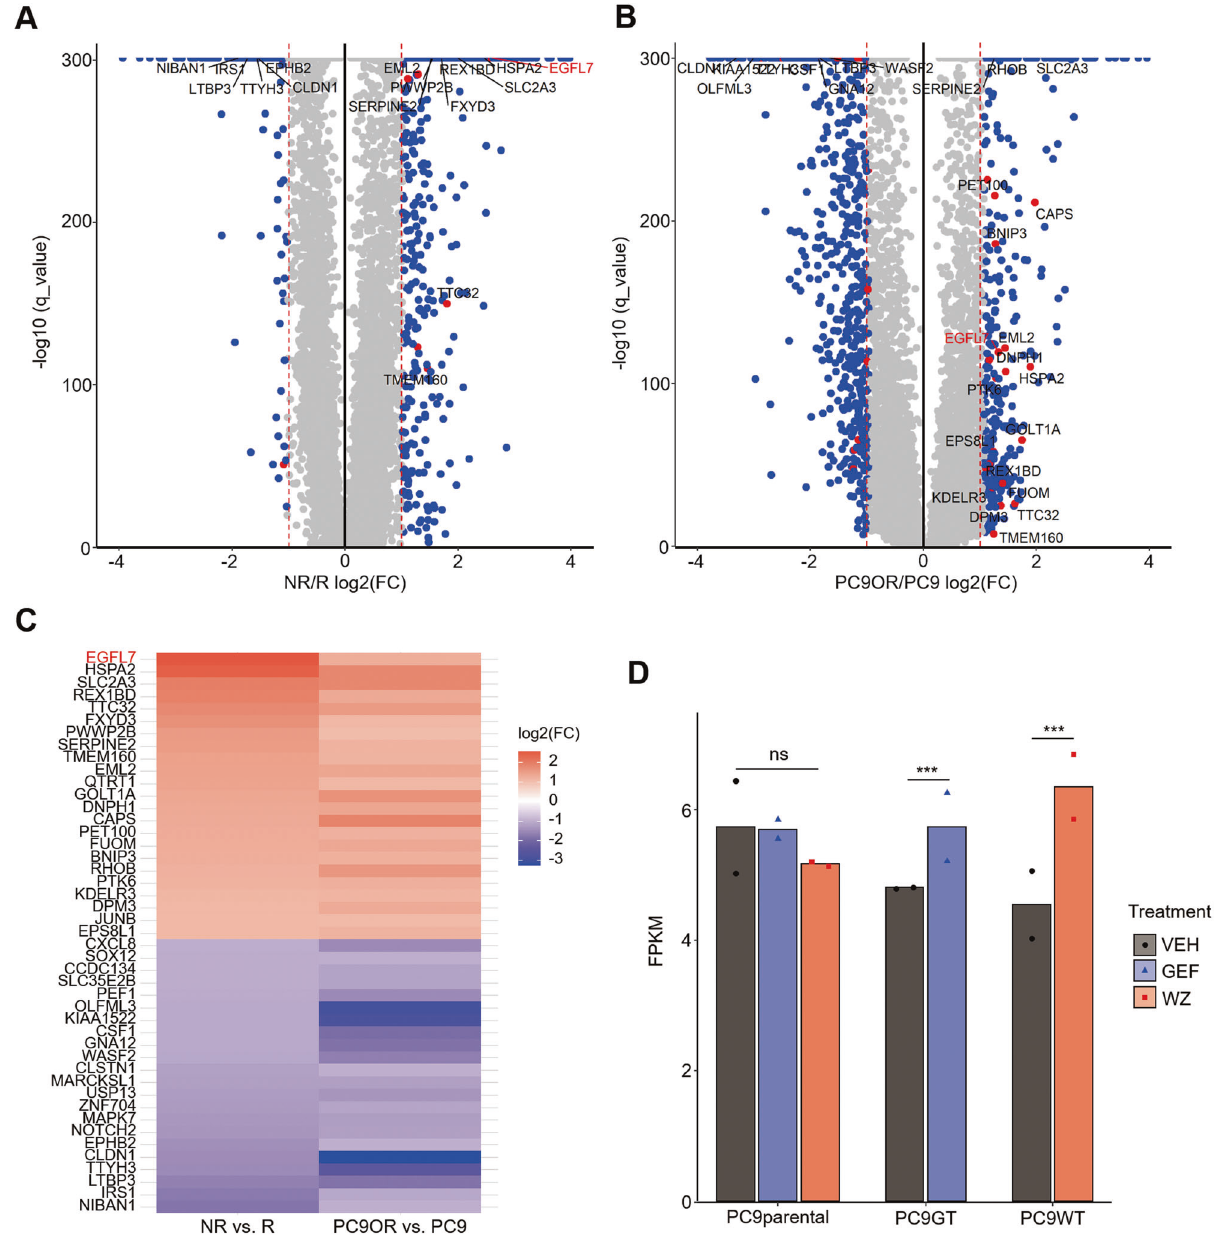
Fig. 1 EGFL7 correlates to EGFR inhibitors resistance in cancer. A Volcano plot representing differential expressed genes between non- responders (NR) and responders (R) to EGFR inhibitors (data from TCGA database). B Volcano plot representing differential expressed genes between PC9OR cells and PC9 cells. Common genes in A and B are represented as red dots. C Heat map showing relative abundance of common differential expressed genes in A and B . D Expression of EGFL7 transcripts in PC9 cells (PC9parental), ge fi tinib-derived PC9 tolerant cells and WZ4002-derived PC9 tolerant cells upon vehicle, EGFR inhibitor ge fi tinib (GEF) or EGFR inhibitor WZ4002 (WZ) treatment (GSE75602). Data are shown as mean values of two replicates. p values are calculated by DEG package in R (see method). (ns, p > 0.05; *** p <